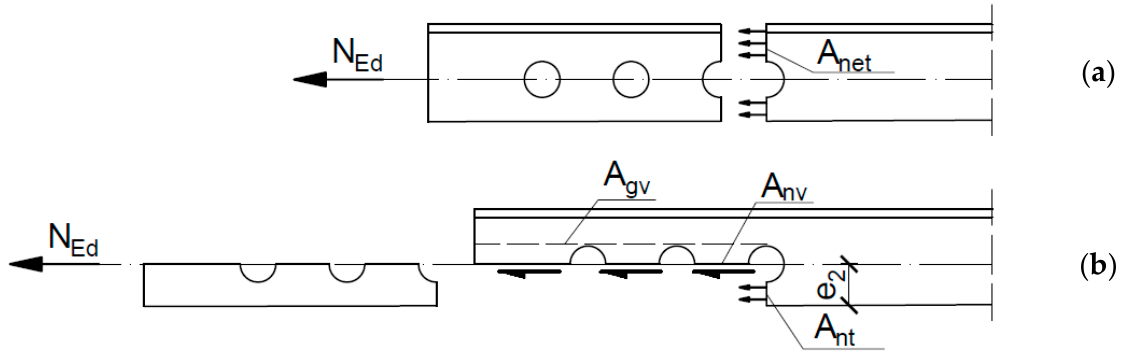
Figure 1. End of the angle weakened by bolt holes; ( a ) the net cross-section area A net , ( b ) cross-section areas subjected to tension and shear.